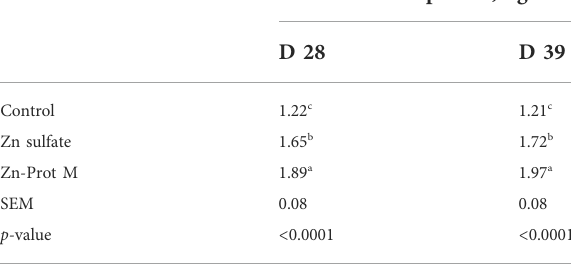
TABLE 5 Effect of dietary Zn source on Zn content in plasma from the hepatic portal vein of 28- and 39-day-old chickens a